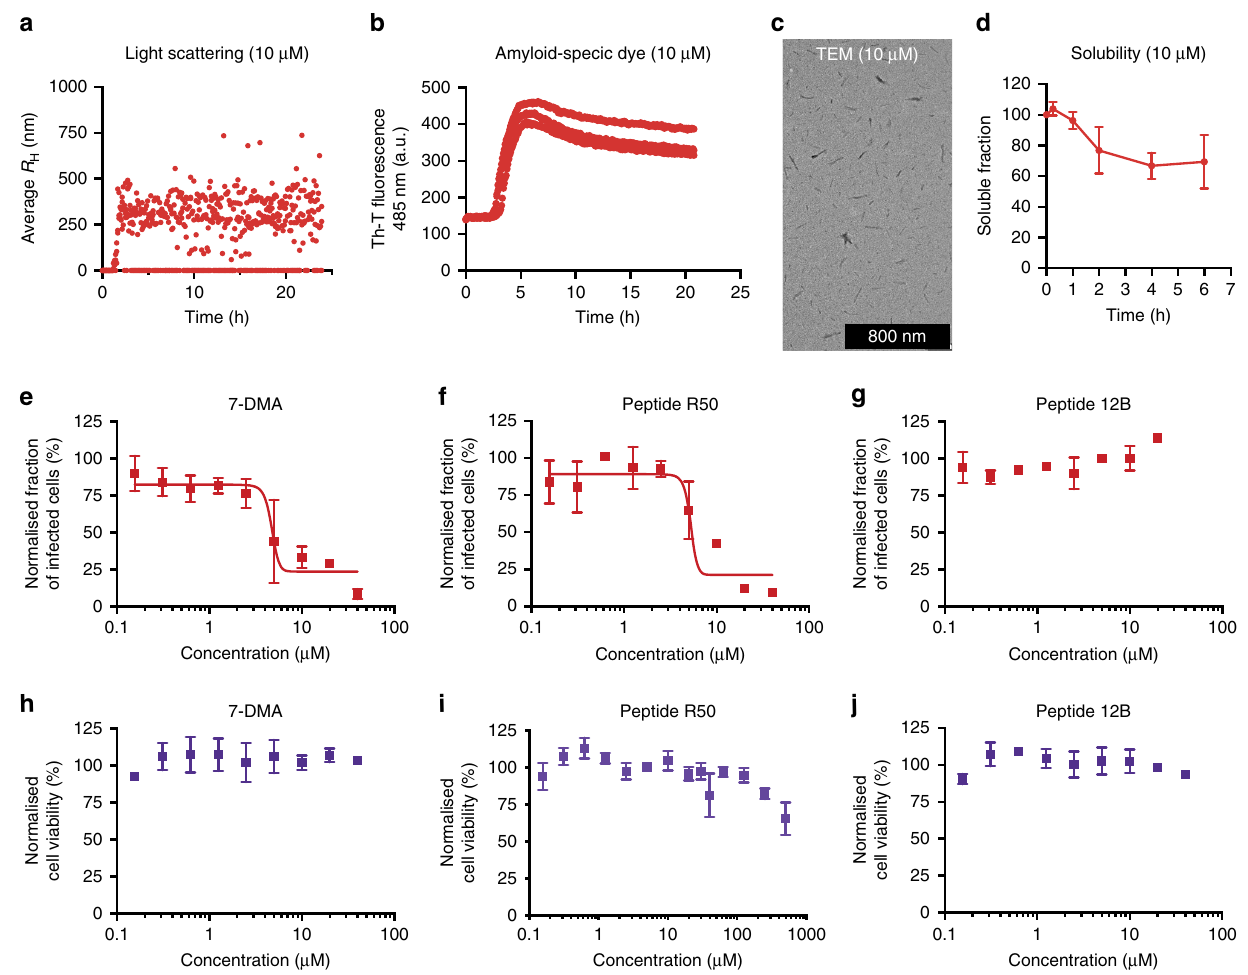
Fig. 6 Peptide R50 organizes into amyloid structures and interferes with ZIKV replication. a Hydrodynamic radius ( R H ) calculated from the regularization fi t of DLS data of peptide R50 (10 µ M) maturation over time. b Th-T emission signal of 10 µ M peptide R50 at 485 nm after excitation at